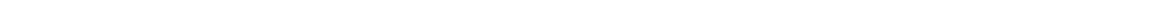
Fig. 2 Gene expression comparison between human T H 1/17 vs. T H 17 cells and mouse pathogenic vs. non-pathogenic T H 17 cells. a The expression